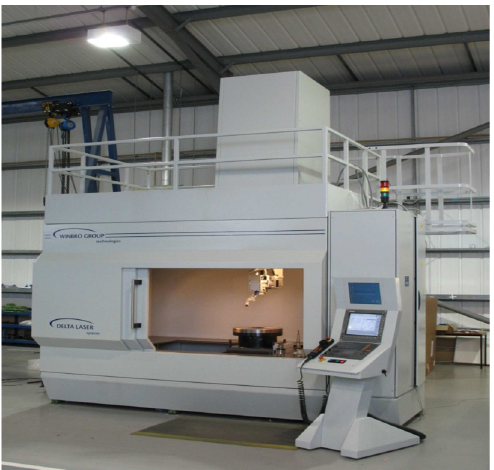
Figure 4. Left picture: Winbro Delta Tornado (Winbro Group Technologies, Coalville, UK), the laser machine used in the experiment [56].